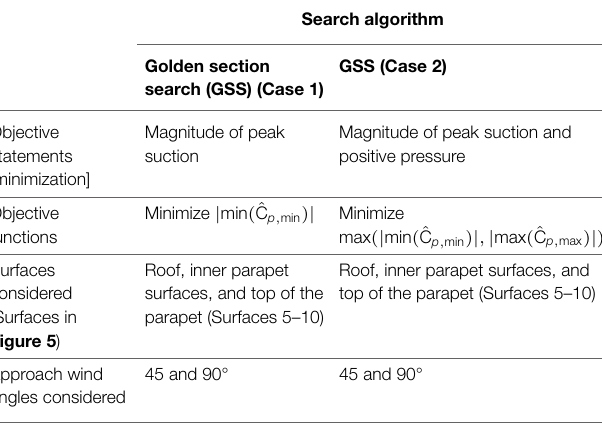
FIGURE 6 | Boundary layer wind tunnel with model low-rise building, upwind view.